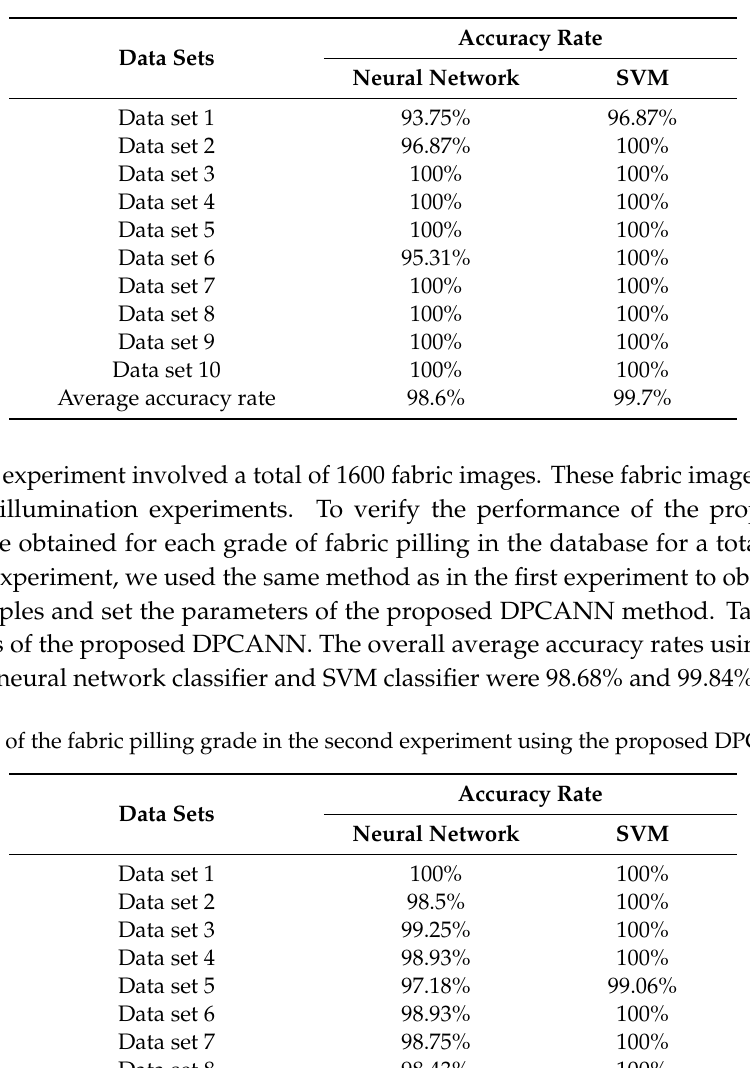
Table 3. Results of the fabric pilling grade in the first experiment using the proposed DPCANN method.